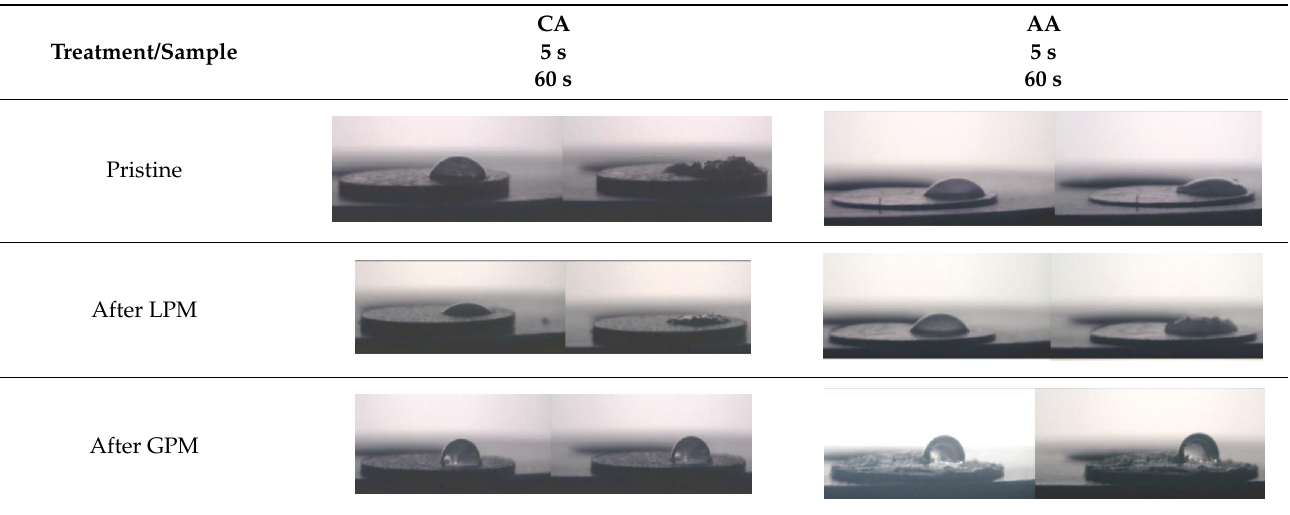
Table 3. Investigation of surface wettability. Contact angle measurement after 5 and 60 s of pristine